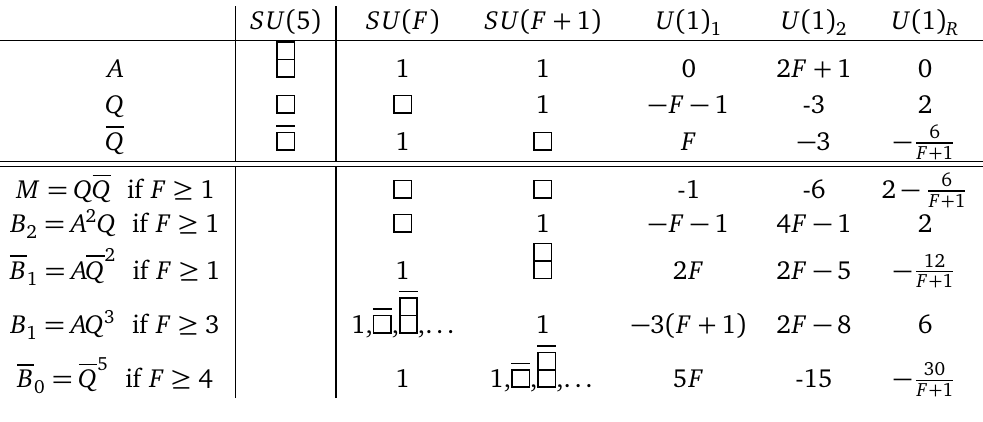
Table 1: Gauge and global quantum numbers of the fields. Top rows: elementary matter fields. Bottom rows: gauge invariant composite